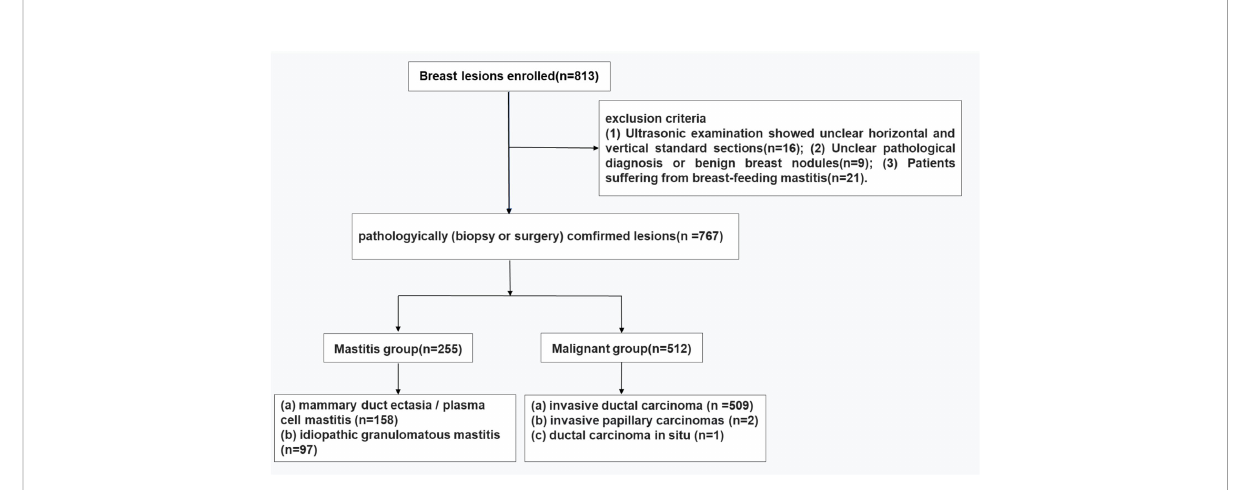
FIGURE 1 Flowchart for lesion